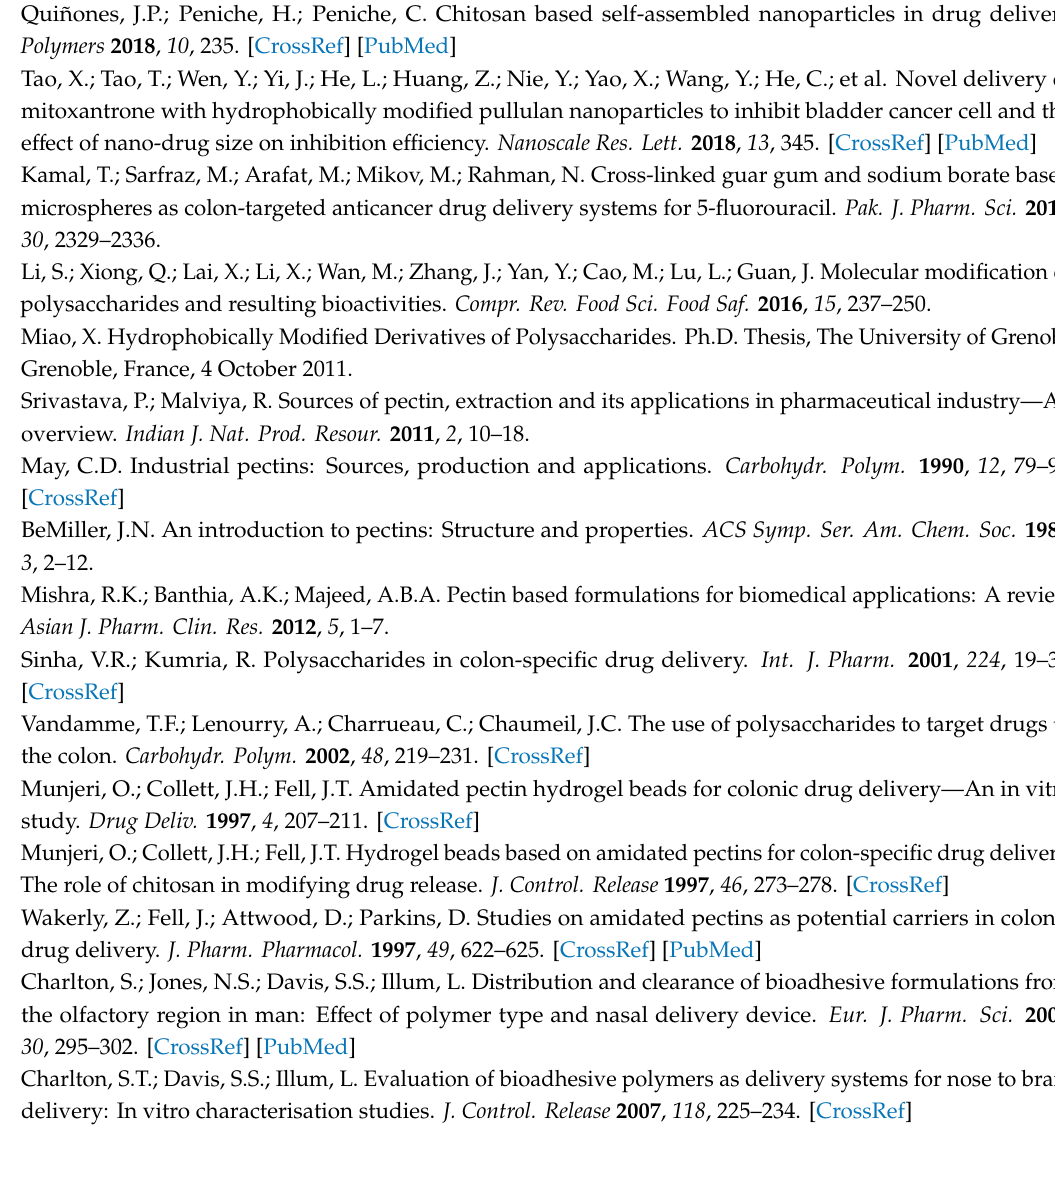
Figure S1: 1 H-NMR spectra of n-butylglycidyl ether (BGE) in deuterated methanol (CD 3 OD) (10 mg /